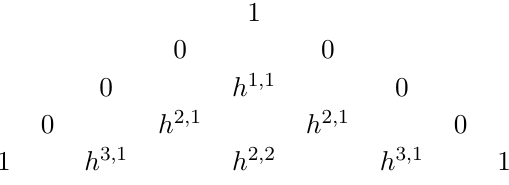
Figure 1 . The Hodge half-diamond of a CY four-fold and its non-trivial entries. h 2 , 2 is not independent but related to the other three